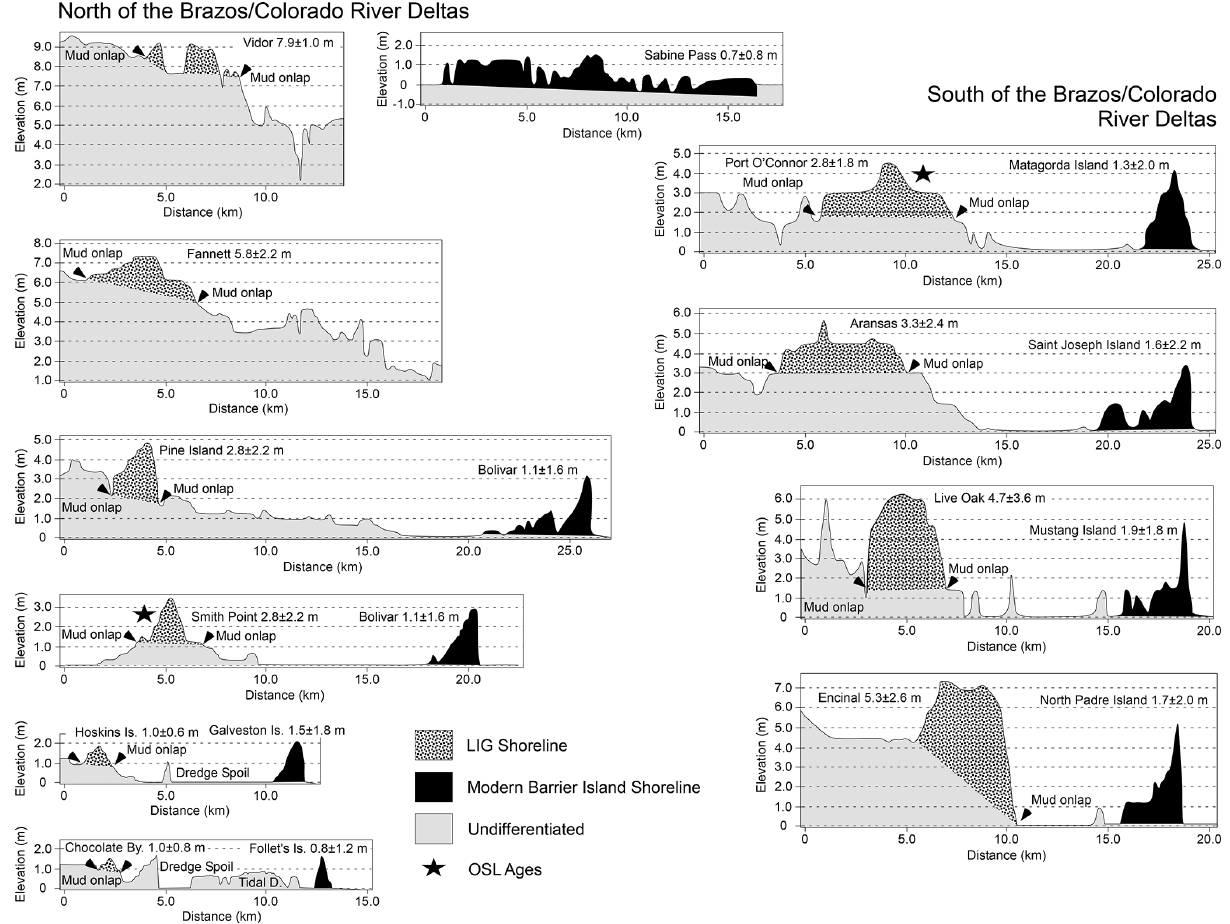
Figure 4. Topographic profiles through selected portions of the Texas coast illustrating the elevation and width differences between the Ingleside and modern barrier islands. See Fig. 3 for general